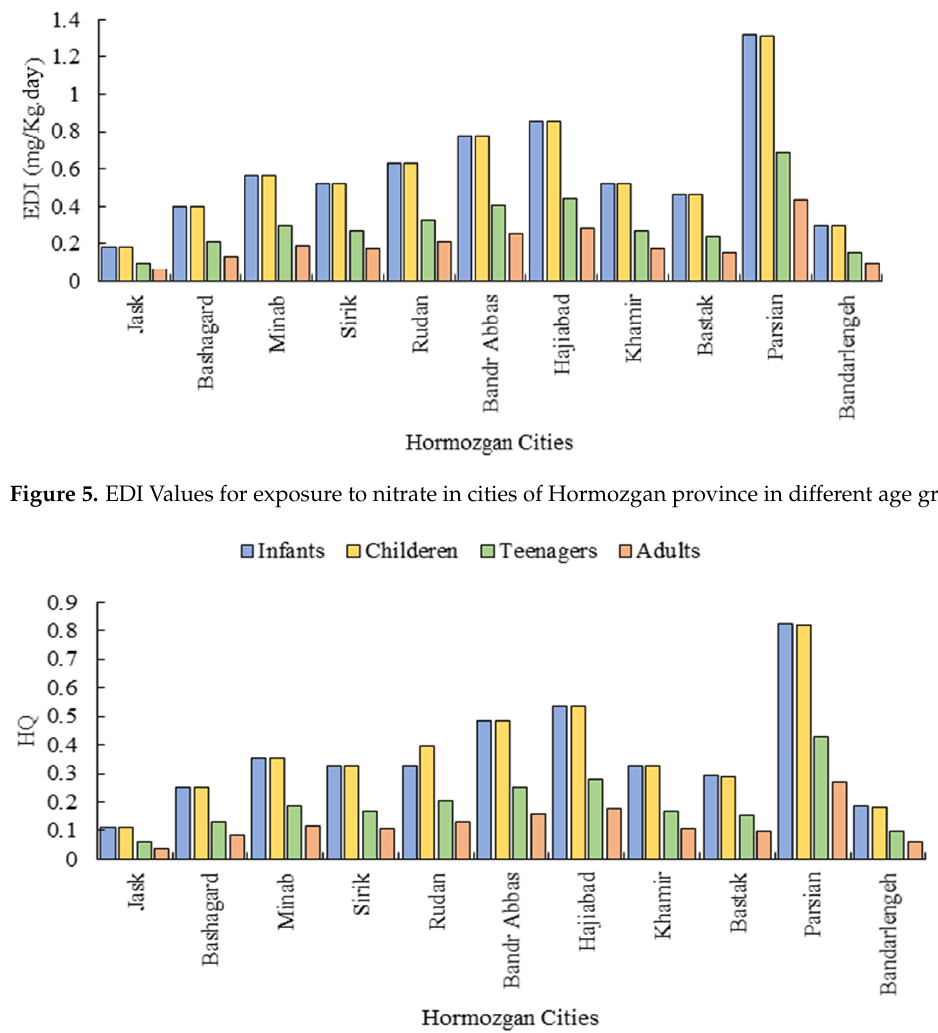
Table 3. Comparative study of nitrate contamination in groundwater of Iran country.